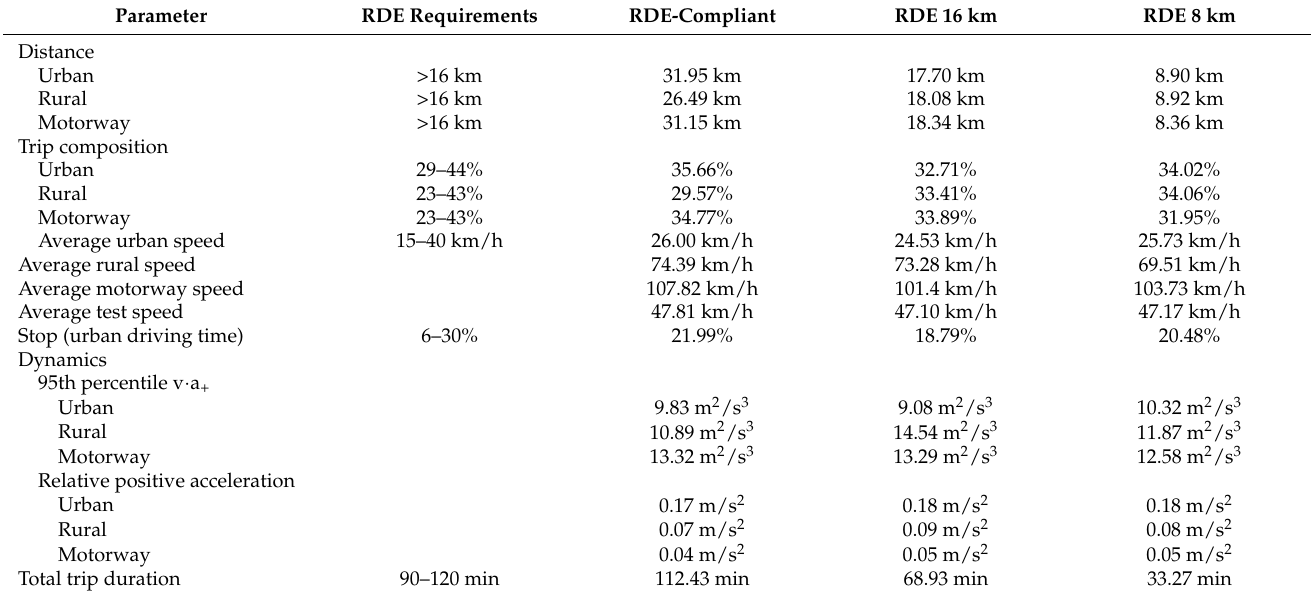
Table A1. Detailed data on RDE-Compliant, RDE 16 km and RDE 8 km tests (average values from 3